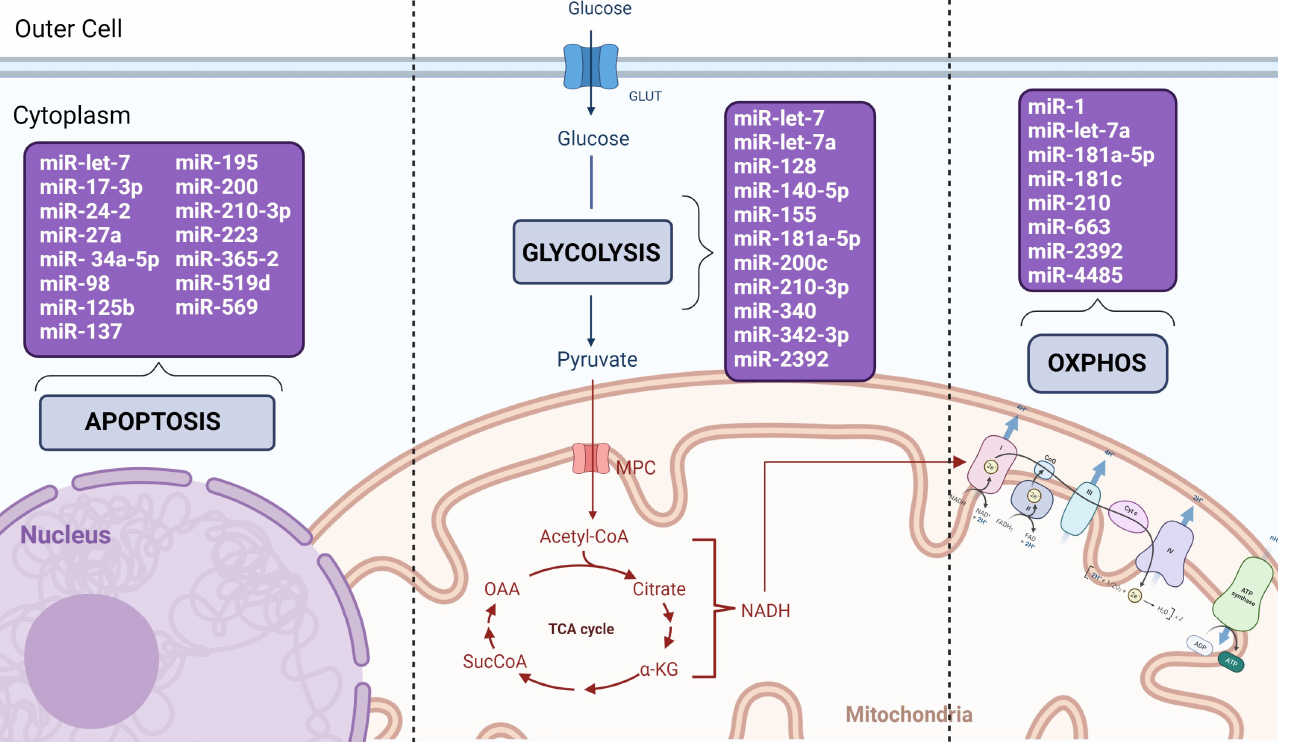
Figure 2. Overview of the involvement of the identified miRNAs in the apoptosis and metabolic processes of the cancer cells. Fifteen miRNAs were identified which suppress or induce apoptosis by regulating the expression of pro-and anti-apoptotic gene-targets. Eleven miRNAs were observed affecting specific steps of glycolysis, from the glucose uptake to pyruvate synthesis, by regulating several glycolytic enzymes. Finally, eight miRNAs directly affected OXPHOS by regulating gene- targets involved in mitochondria function and homeostasis. Table 1. MiRNAs identified with oncogenic function, their target genes, mechanism of action, and corresponding impact on distinct cancer cells phenotypes (presented by type of cancer).